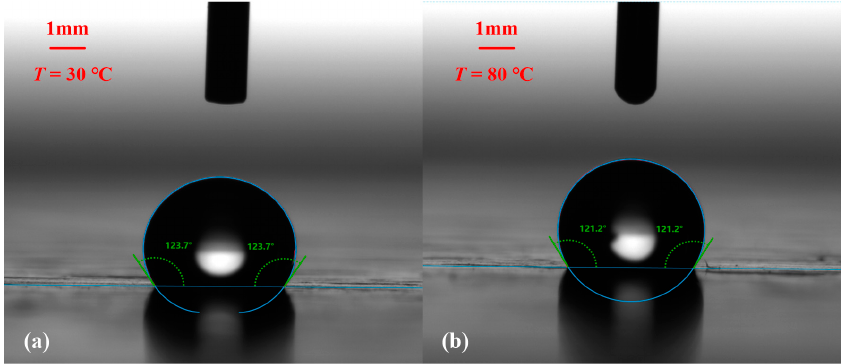
Figure 2. Images of contact angle measurement under ( a ) 30 °C and ( b ) 80 °C.